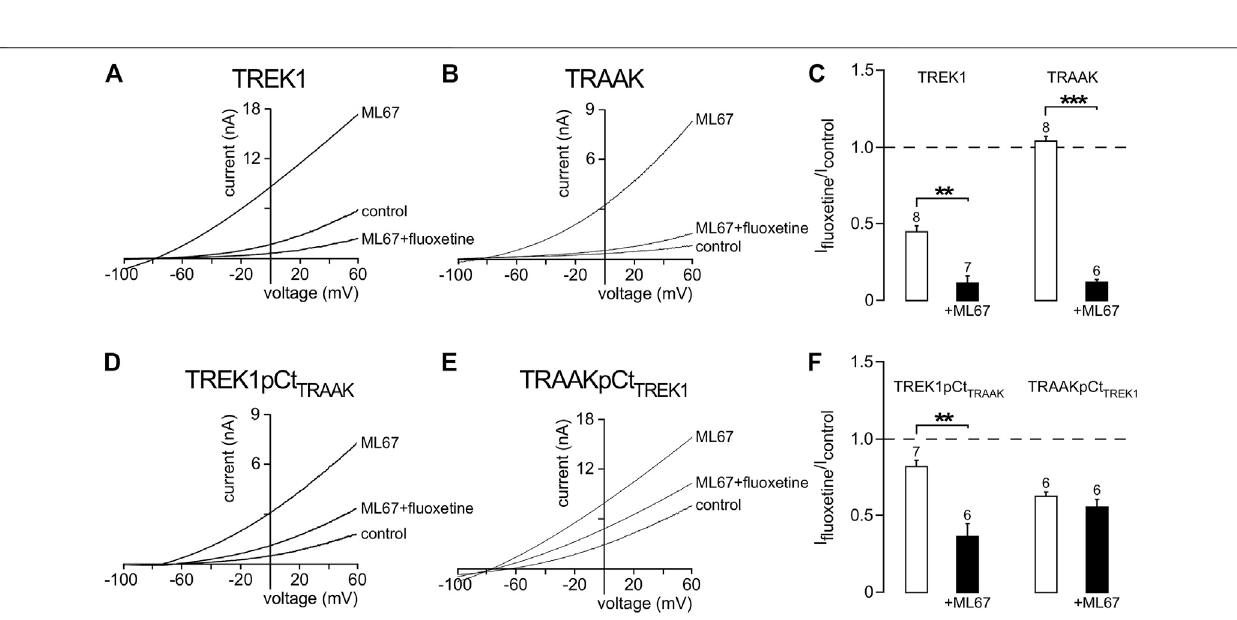
Frontiers in Pharmacology |